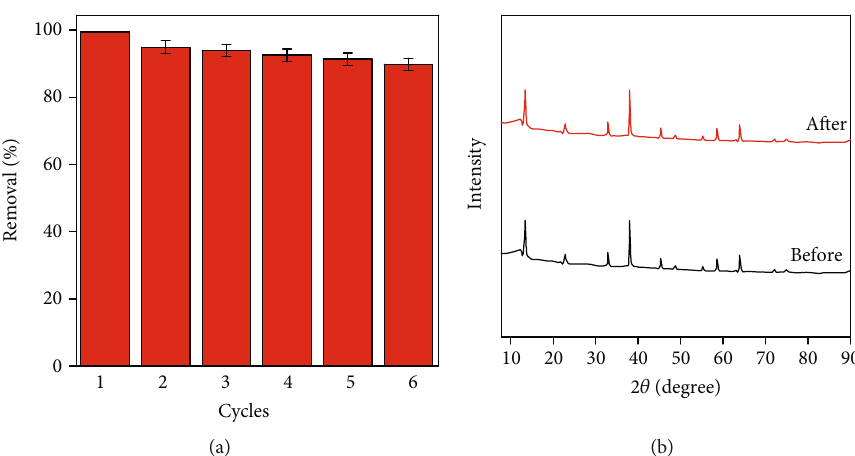
Figure 7: Reusability of MOF/NH composite before and after MO dye adsorption